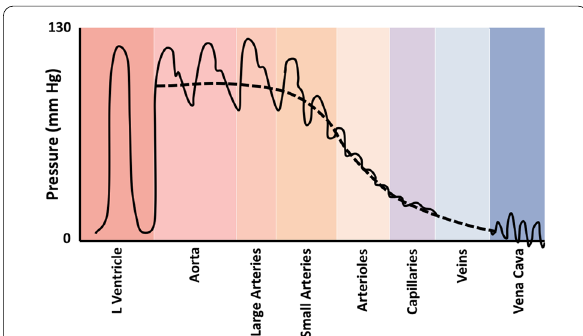
Fig. 1 Pressure at different points in the circulatory system. Note the precapillary arteriolar pressure is substantially lower than the large arterial pressures